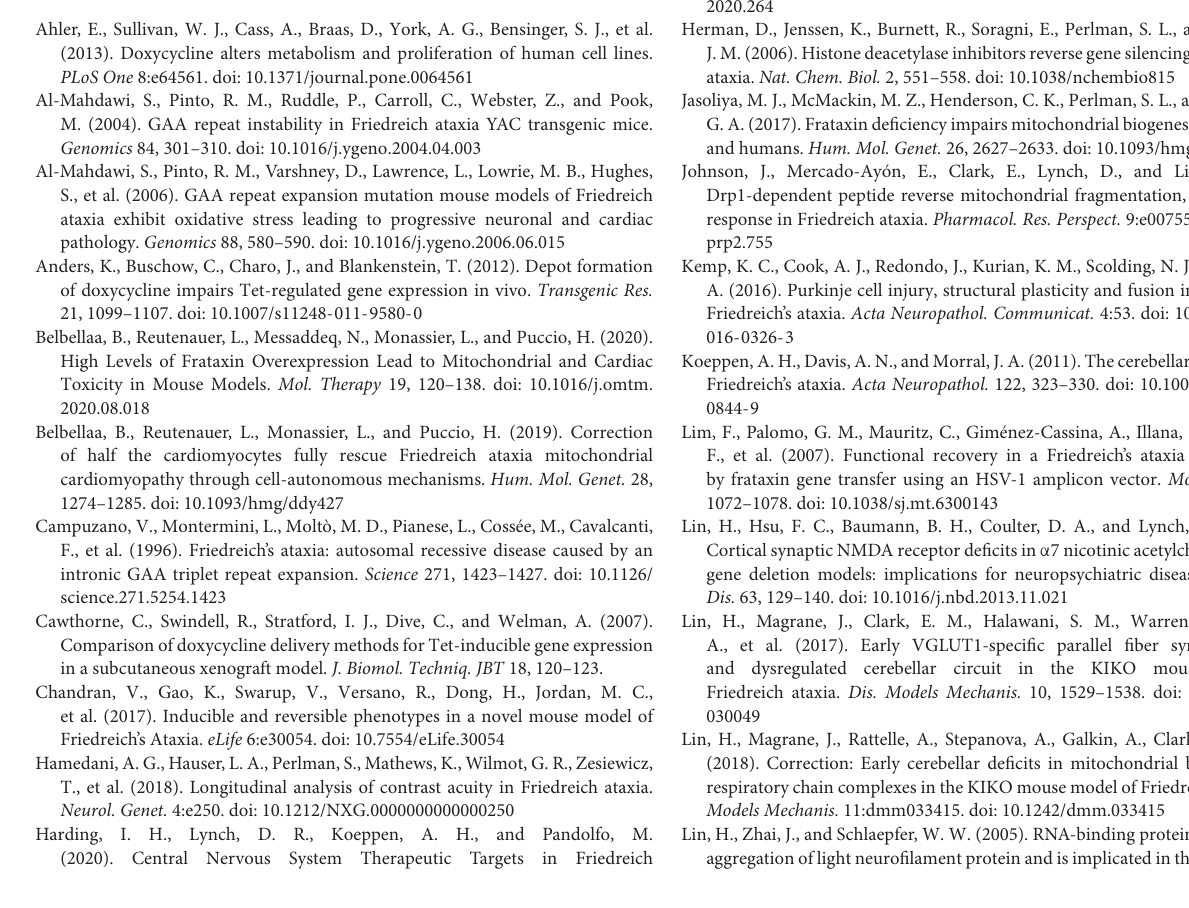
(A) Western blot analysis of frataxin and internal loading (Actin) levels in cerebellum, DRG, spinal cord (SC), and cortex. (B) Quantification analysis of frataxin levels normalized to internal control actin. (C) Western blot analysis of frataxin and internal loading control (SM-Actin, GAPDH, and Tubulin respectively) levels in heart, skeletal muscle, and liver. (D) Quantification analysis of frataxin levels normalized to internal control (SM-Actin, GAPDH, Tubulin respectively). The frataxin expression levels are reported as a percentage to mean values of wild-type mice as 100 percent ( ∗ P < 0.05, ∗∗ P < 0.01, ∗∗∗ P < 0.001, # P < 0.05, ## P < 0.001, two-tailed, unpaired Student’s t -test, error bars represent mean ± SEM for each panel. WT, n = 3, TG + , n = 3). Supplementary Figure 2 | Pathological analysis revealing histological evidence of toxicity in FRDAkd mice that was exacerbated by high dose PGK- FXN. Supplementary Figure 3 | Neuronal loss in the cerebellar cortex, dentate nucleus, and DRG of Dox-compounded feed FRDAkd mice at 12-week of Dox-induction. Hematoxylin-Eosin staining shows loss of cerebellar Purkinje neurons (B) , large DN principal neurons (D) , and large DRG sensory neurons (F) compared with those neurons in control mice (A,C,E) . Scale bars as indicated (25 µ m). Supplementary Figure 4 | Older FRDAkd mice induced by dox-compounded feed display severe body weight loss. TG+ mice older than 6 months of age at Dox-induction show a higher percentage of weight loss of over 20% at 18 weeks compared with those at 2–5 months of age. (TG+, n = 17; TG-, n = 17; WT+, n = 10; WT-, n = 10). * P < 0.05,** P < 0.01,*** P < 0.001, ns not significant. One way ANOVA test followed by t